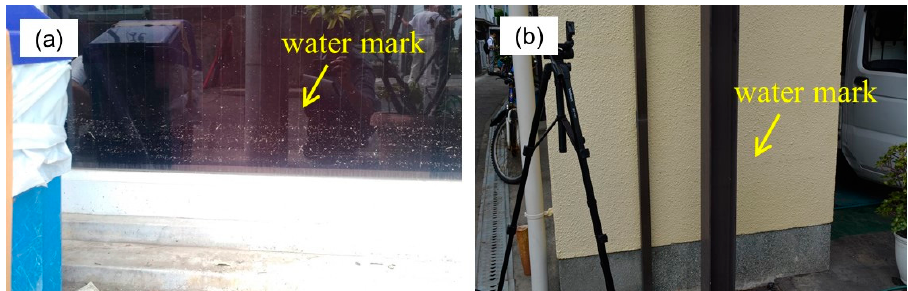
Figure 5. Photographs taken by the authors at Higashi-Kawasaki town. ( a ) Survey Point H2 (watermark on a window); ( b ) Survey Point H3 (watermark is indicated by a yellow allow).